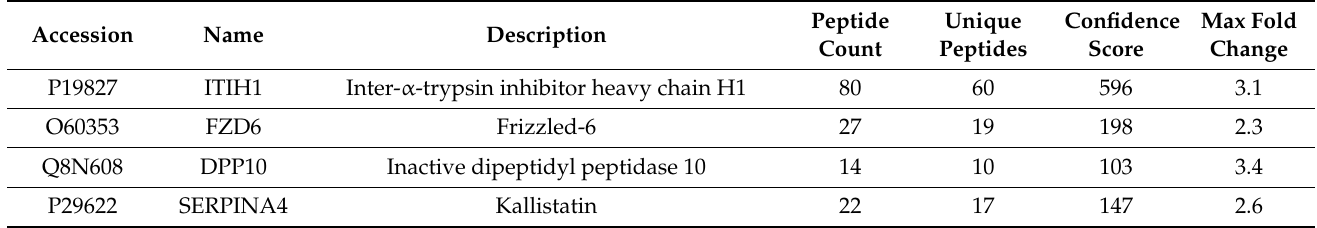
Table 4. 10GC-P: GC-specific serum proteins chosen for orthogonal validation as serum markers, sorted by decreasing intensity, and their detection results (fold value for GC vs. NGM, average intensities from 2799–242760 counts in GC